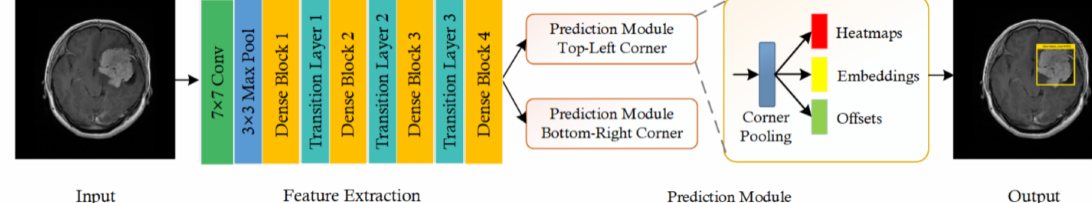
Figure 1. Proposed methodology diagram with four modules: Input, Feature Extraction using DenseNet-41 having four dense blocks and 3 transition layers, Prediction module to localize and classify the brain tumor by generating the bounding box along with confidence score, and finally, the obtained visual result as Output.